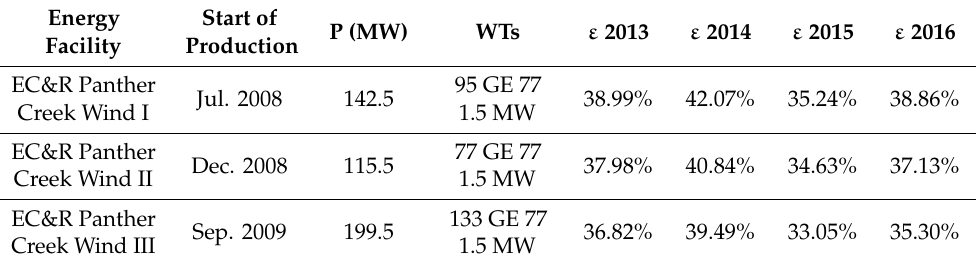
Table 5. EC&R Panther Creek Wind Energy Center (TX).